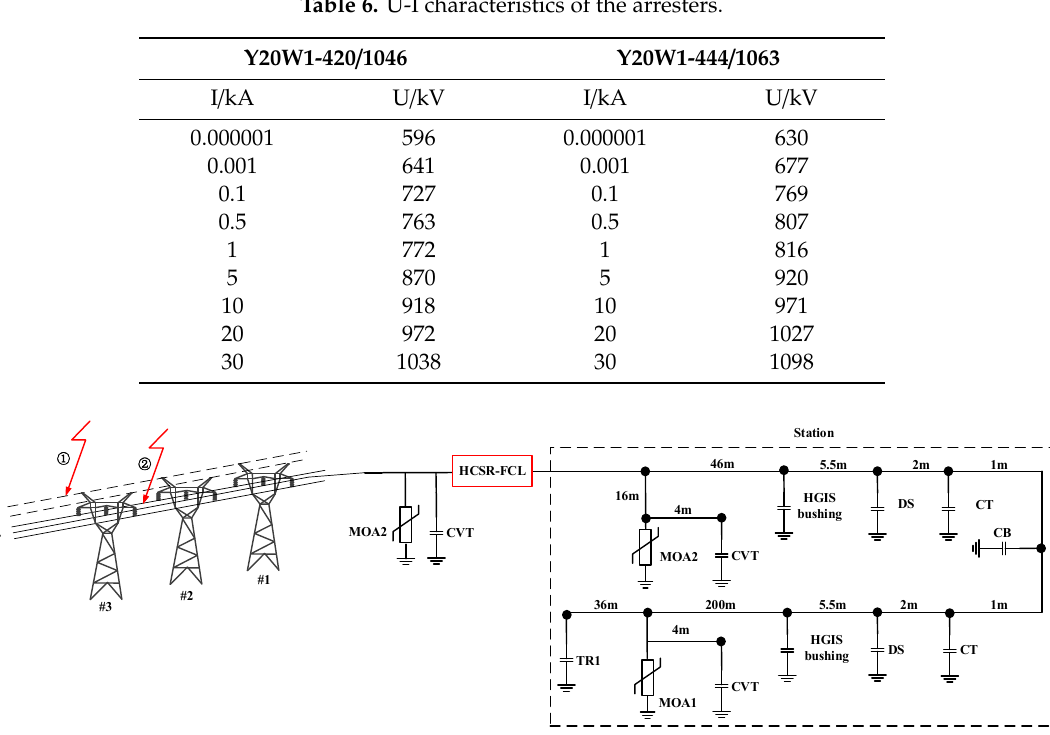
Figure 4. Equivalent circuit of 500 kV Guangnan station connected with the HCSR-FCL.